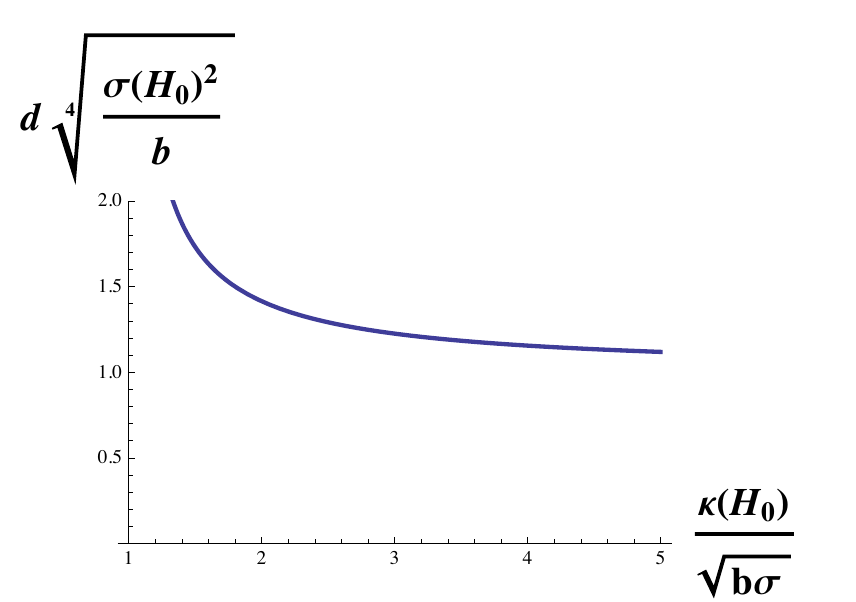
) 1/4 is plotted vs. κ H ( b σ ) 1/2 , the bending modulus in 0 / 0